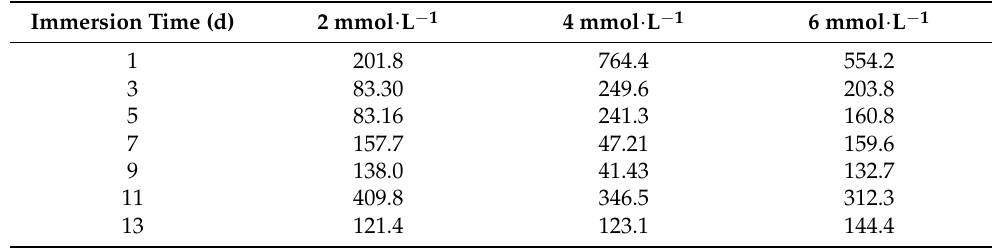
Table 3. R ct values obtained by EIS fitting of magnesium alloy AZ63B immersed in 3.5% NaCl solution with different concentrations of S 2 − .